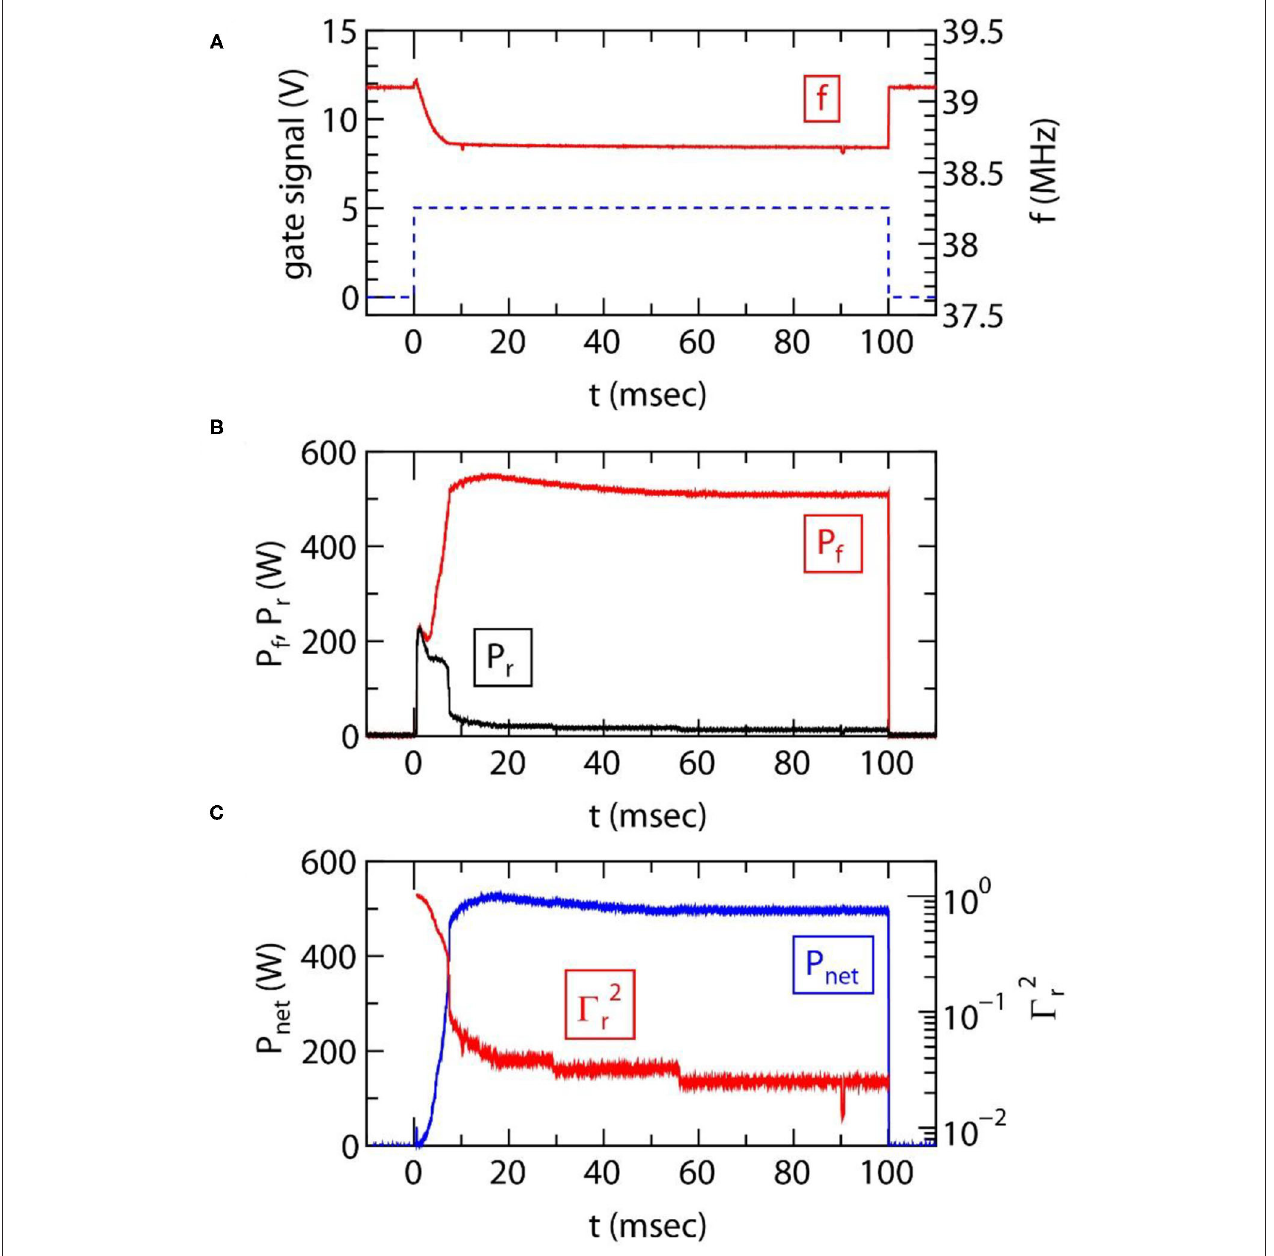
FIGURE 3 | Temporal evolutions of (A) the rf gate signal (a dashed line), the frequency f of the rf power (a red solid line), (B) the forward power P f (a red solid line), the reflected power P r (a black solid line), (C) the net rf power P net (a blue solid line), and the square of the reflection coefficient Γ 2 r (a red sold line), where the pulse width of the rf power, the initial value of the frequency, and the target value of the net power, are set at 100 msec, 39.1 MHz, and 500W,